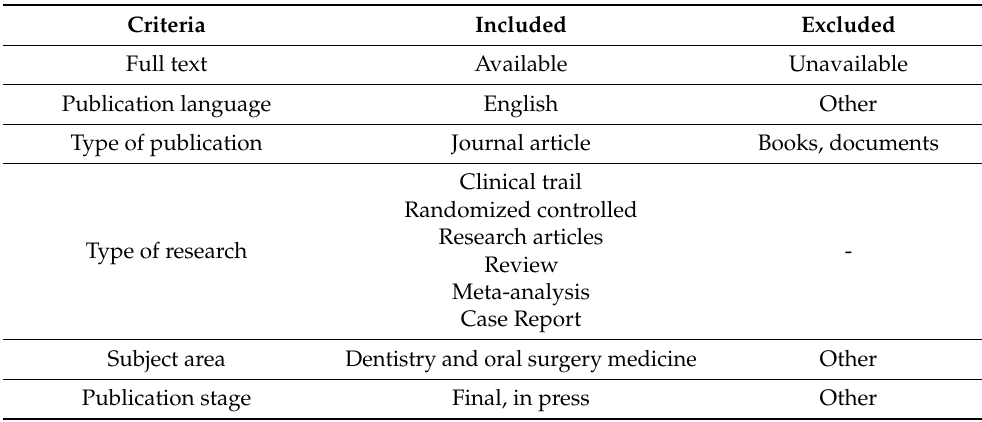
Table 3. Exclusion and inclusion criteria.